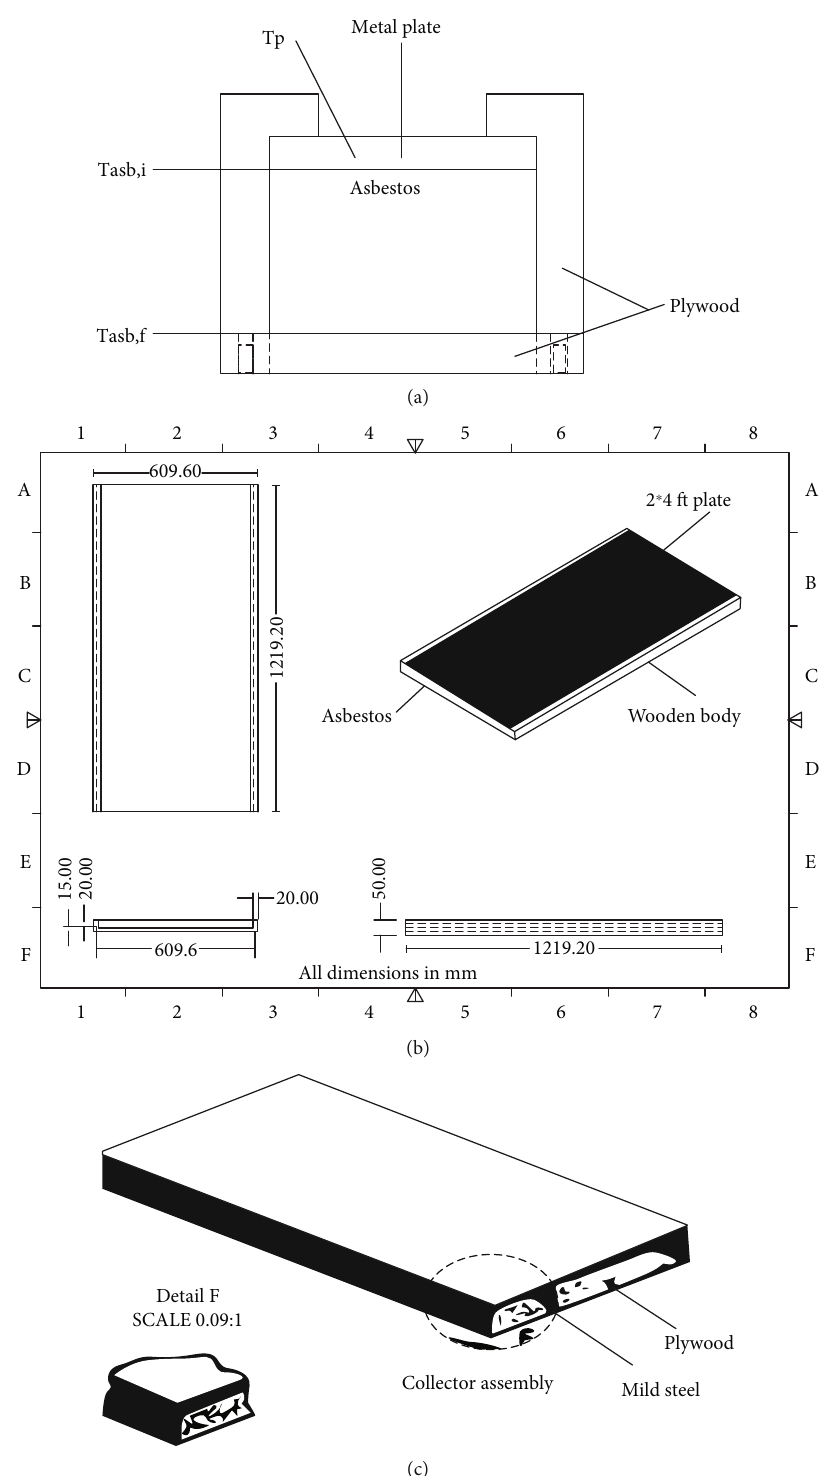
Figure 1: Solar Flat Plate construction showing its various components: (a) sectional view, (b) orthogonal view, and (c) pictorial